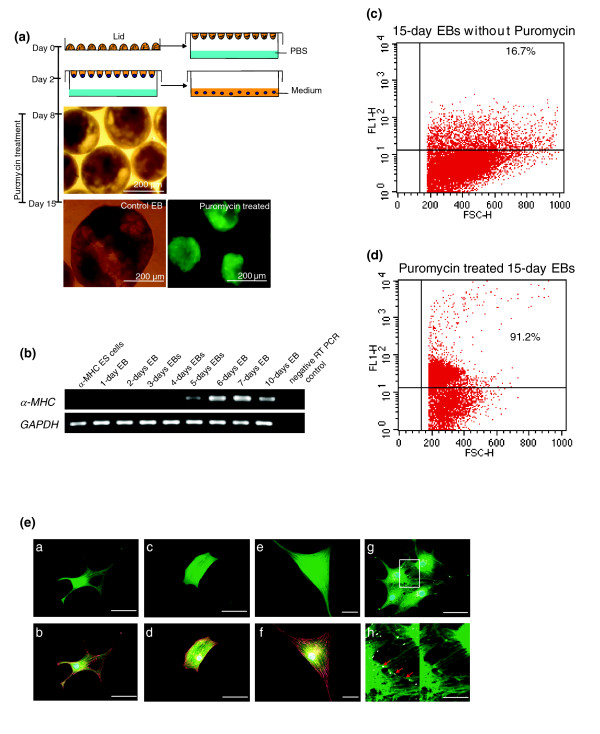
Enrichment of α-MHC+ cells isolated from the α-MHC+ ES cell lineage after puromycin treatment. (a) Progressive purification of α-myosin heavy chain (MHC)+ cardiac cell aggregates after treatment of the 8-day-old embryoid bodies (EBs) with 4 μg/ml puromycin for 7 days. Puromycin containing medium was refreshed every second day. (b) Reverse transcription (RT)-polymerase chain reaction (PCR) analysis of α-MHC expression during EB differentiation (for RT-PCR conditions and primers, see Additional data file 3). (c,d) Cells from 15-day-old EBs and 15-day-old puromycin purified α-MHC+ aggregates were dissociated by trypsinization and the purity of the α-MHC+ cells in the 15-day-old EBs (panel c) and in the 15-day-old α-MHC+ aggregates (panel d) was examined by fluorescence-activate cell sorting analysis. (e) Characterization of ES cell derived cardiomyocytes by immunocytochemistry. α-MHC+ cardiomyocytes were dissociated with collagenase B and plated on fibronectin coated coverslips. (e) Enhanced green fluorescent protein (EGFP) expression of single α-MHC+ cells with different morphologies (subpanels a, c, and e). Detection of α-cardiac actinin (subpanels b, d, and f) and connexion-43 (subpanels g and h) was performed using anti-cardiac actinin (1:400) and anti-connexin-43 (1:400). Secondary detection was performed with anti-mouse-IgG1-AlexaFluor555 and anti-rabbit-Ig-AlexaFluor647. Hoechst dye was used to stain nuclei. Bars in panel e (subpanels a to f) are 50 μm; bar in panel e (subpanel g) is 20 μm; and bar in panel (subpanel h) is 7.5 μm.